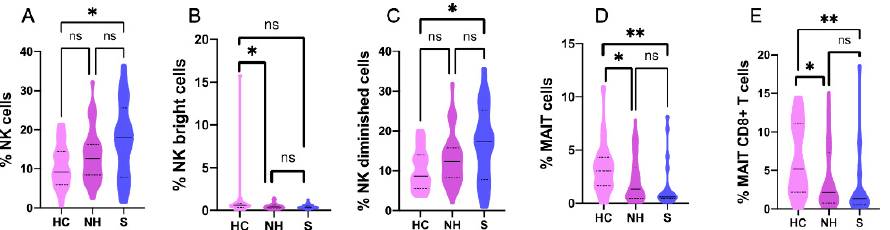
Figure 1. Innate immunological profile distribution in healthy controls (HC, n = 21), non-hospitalized (NH, n = 38), and severe COVID-19 patients (S. n = 24). ( A ) NK cells; ( B ) NK bright cells; ( C ) NK dim cells; ( D ) CD3+ MAIT cells; ( E ) CD8+ MAIT cells. HC, healthy controls; NH, Non-Hospitalized; S, Severe; ns, no significant; *, p < 0.05; **, p < 0.01.